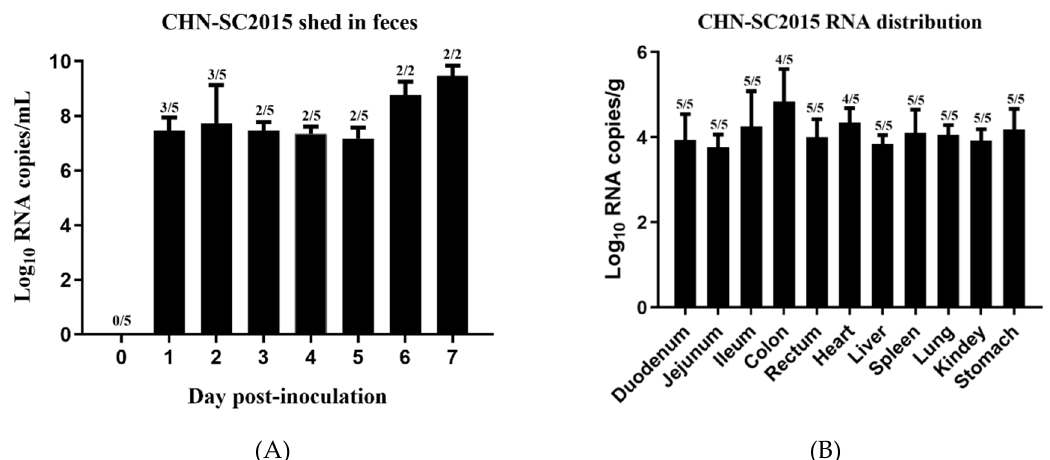
Figure 12. Viral shedding and distribution in the challenged piglets. ( A ) The five-day-old piglets were infected with PDCoV CHN-SC2015 and viral shed in feces was quantitated daily from two or three of the challenged piglets. ( B ) The five-day-old piglets were infected with PDCoV CHN-SC2015 and distribution of CHN-SC2015 in the intestines and internal organs was assayed after necropsy.